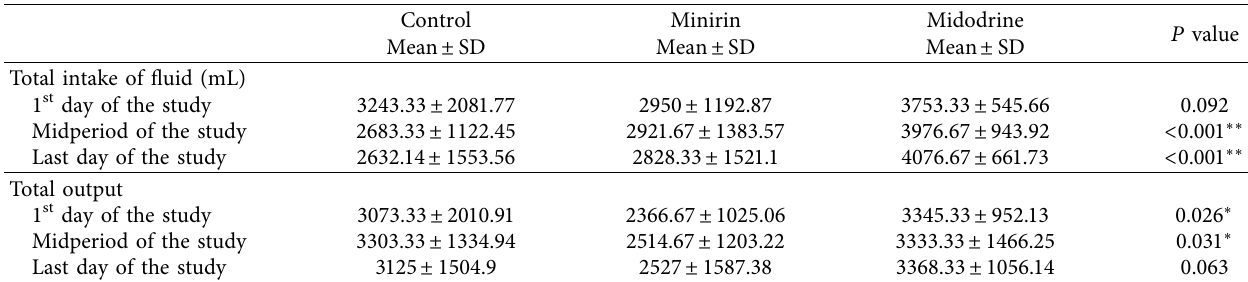
Table 3: Comparison between the studied groups regarding the total intake of fluid and total output ( n �